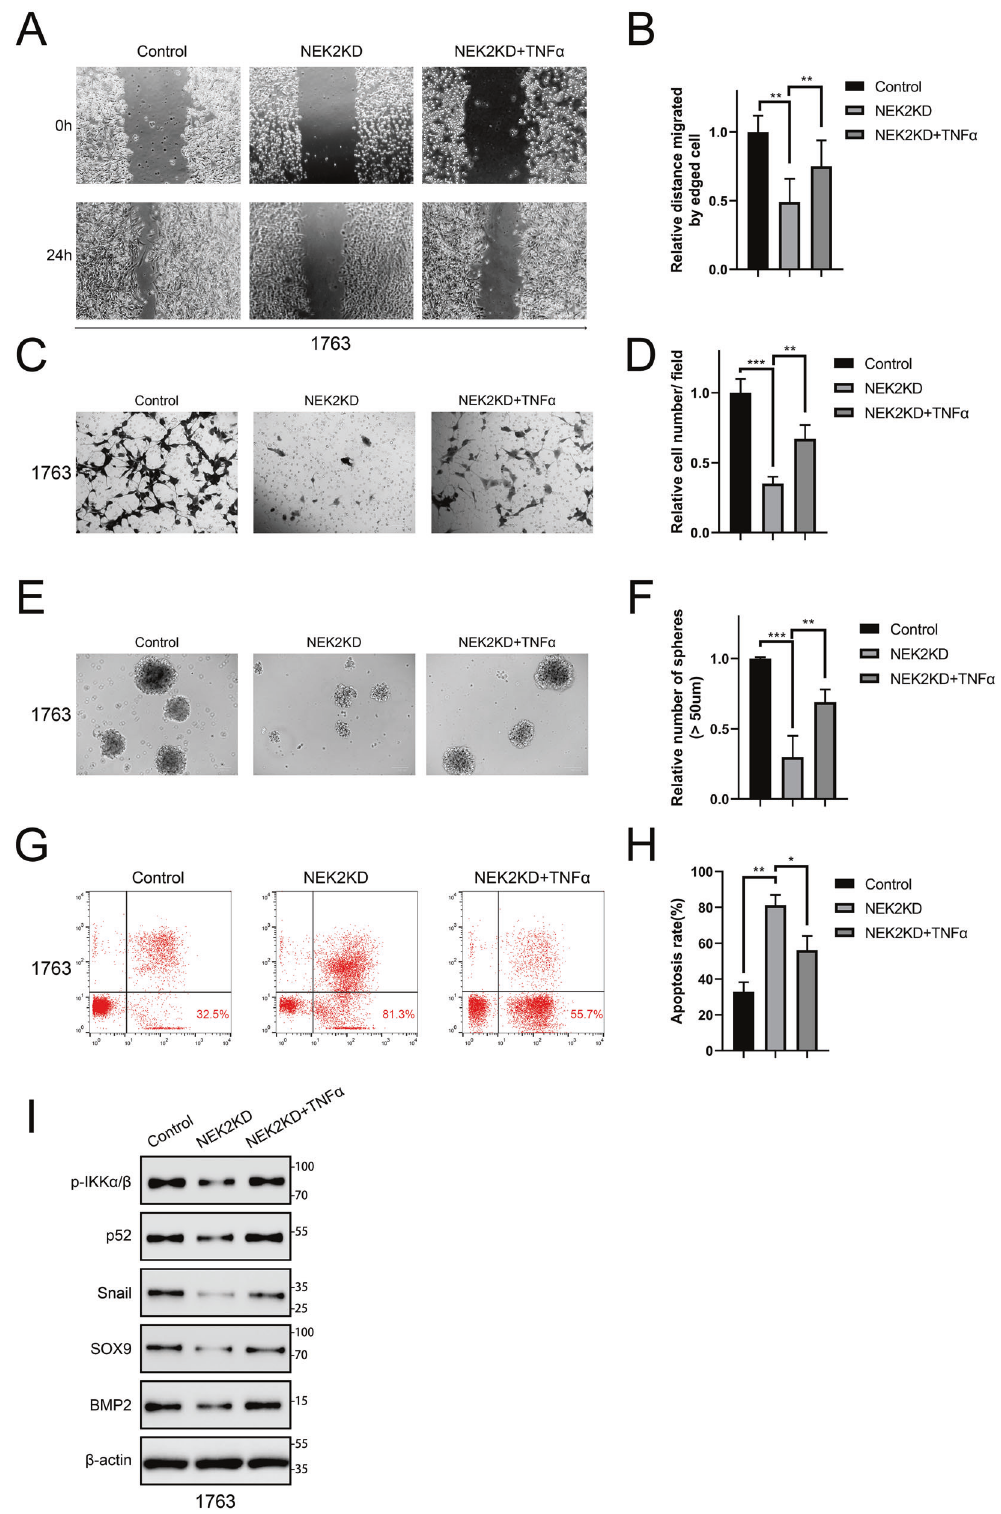
Fig. 5 NEK2 promoted gliomagenesis and the malignancy of GBM via activation of NF- κ B signaling. A , B Wound healing assays for exploring the effect of TNF- α on tumor malignancy in NEK2 knockdown GBM cells. C , D Matrigel invasion assays were used to verify the promotion of TNF- α on invasive ability in NEK2 knockdown GBM cells. E , F Sphere formation assays were performed to detect the sphere formation ef fi ciency of NEK2 knockdown cells pretreated with TNF- α , NEK2 knockdown cells and negative control cells. G , H Flow cytometry analysis was carried out to measure the effect of TNF- α on the apoptotic ratio in NEK2 knockdown GBM cells. I Western blot assays were performed to detect the protein levels of the NF- κ B signaling pathway as well as its downstream targets in NEK2 knockdown GBM cells pretreated with or without TNF- α